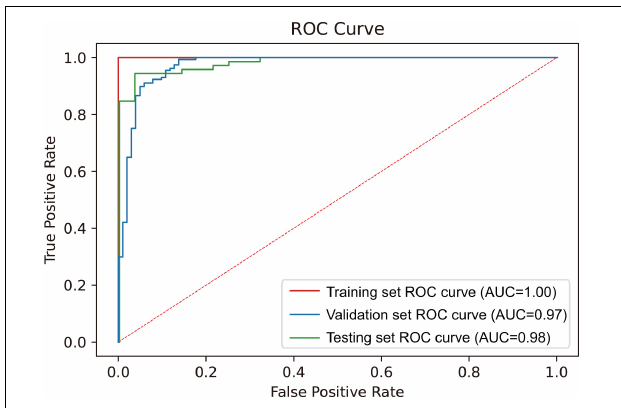
FIGURE 4 | ROC curve of the training set, validation set, and testing set.